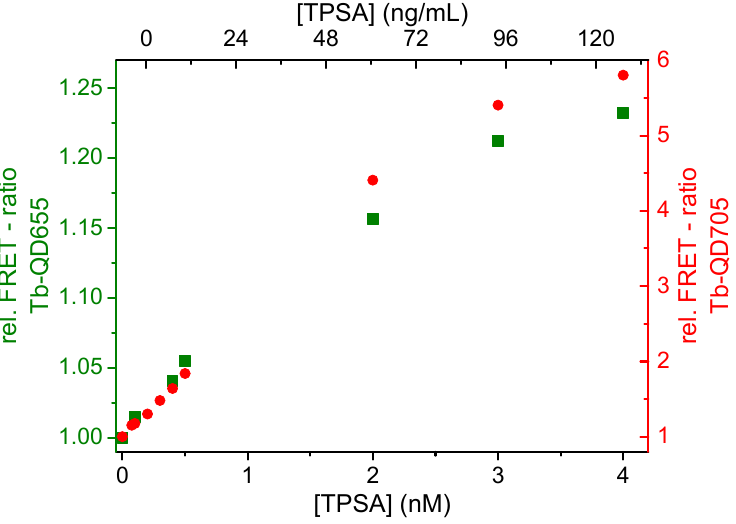
Figure 4. PSA immunoassay calibration curves for the detection of PSA in a duplexed detection format using the Tb-QD655 ( green ) and Tb-QD705 ( red ) FRET-ratios measured from the same samples (for each concentration) that contained both QD655 and QD705 AB conjugates.